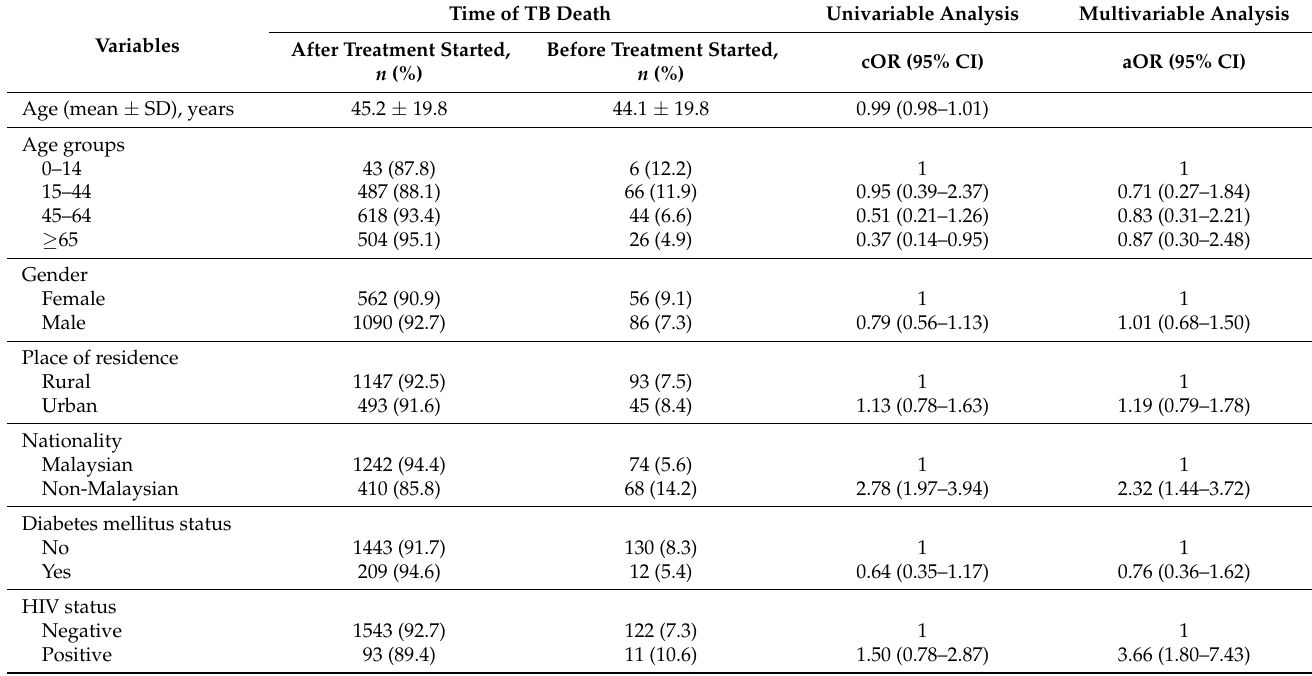
Figure 2. Frequency of TB-related, non-TB-related, and all TB deaths by timing of death. Table 3. Binary logistic regression analysis for risk factors of all-cause TB death before treatment started.